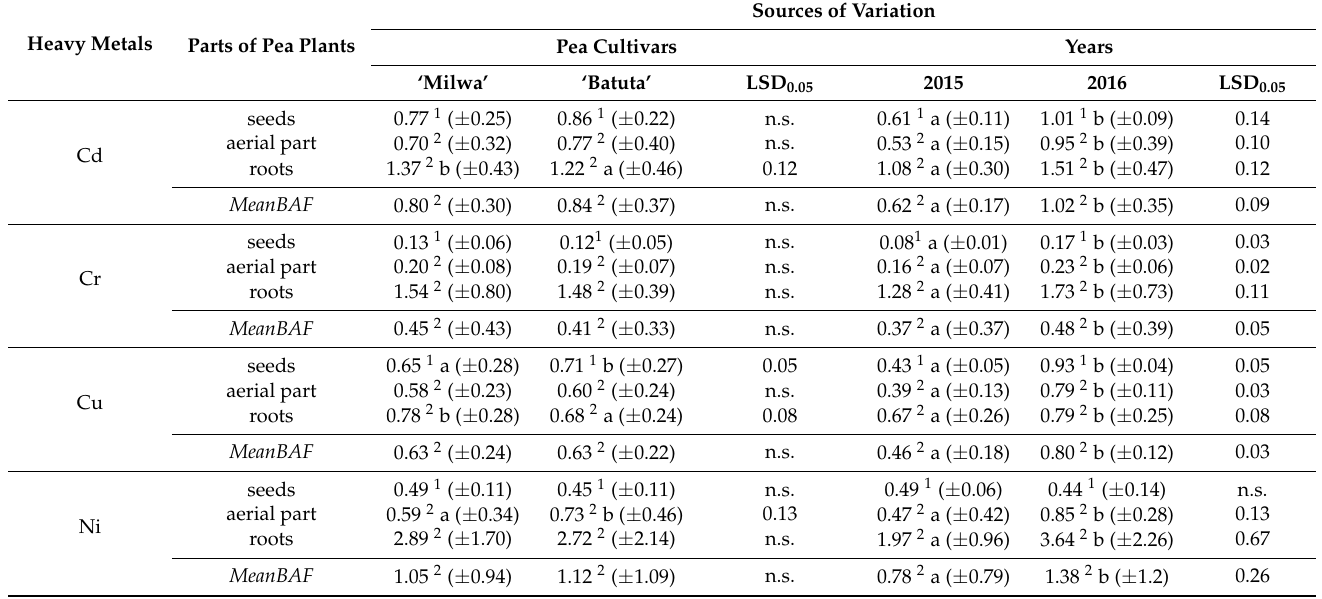
Table 10. BAF of heavy metals in pea plants ( 1 mean values in maturity ± SD of two successive years or two cultivars, respectively, and with three repetitions each; 2 mean values ± SD of six growth stages, two successive years or two cultivars, respectively, and with three repetitions